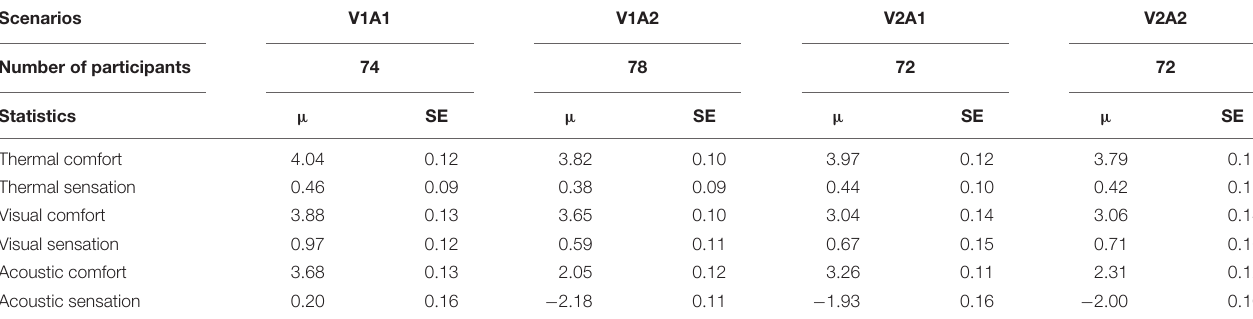
TABLE 7 | Mean ( µ ) and SE of thermal, visual, and acoustic sensation and comfort votes of participants.